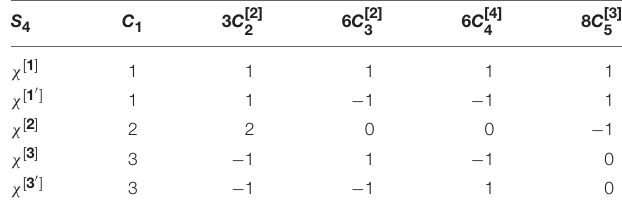
TABLE 2 | Characters of the S 4